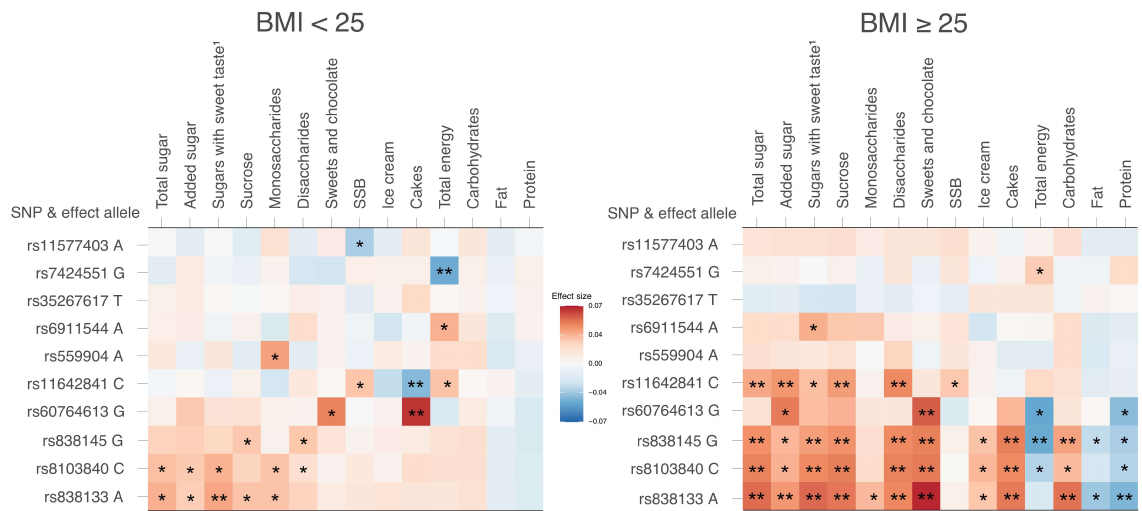
Figure 3. Sensitivity analyses studying participants with BMI <25 and ≥25 separately. The figure shows results for the 10 primary SNPs and all outcomes. The effect sizes are presented as β/SEE. SEE: Standard error of the estimate. 1 Sucrose 10 primary SNPs and all outcomes. The effect sizes are presented as β /SEE. SEE: Standard error of the estimate. 1 Sucrose and all monosaccharides. * p < 0.05, ** p < 0.005. and all monosaccharides. * p < 0.05, ** p <